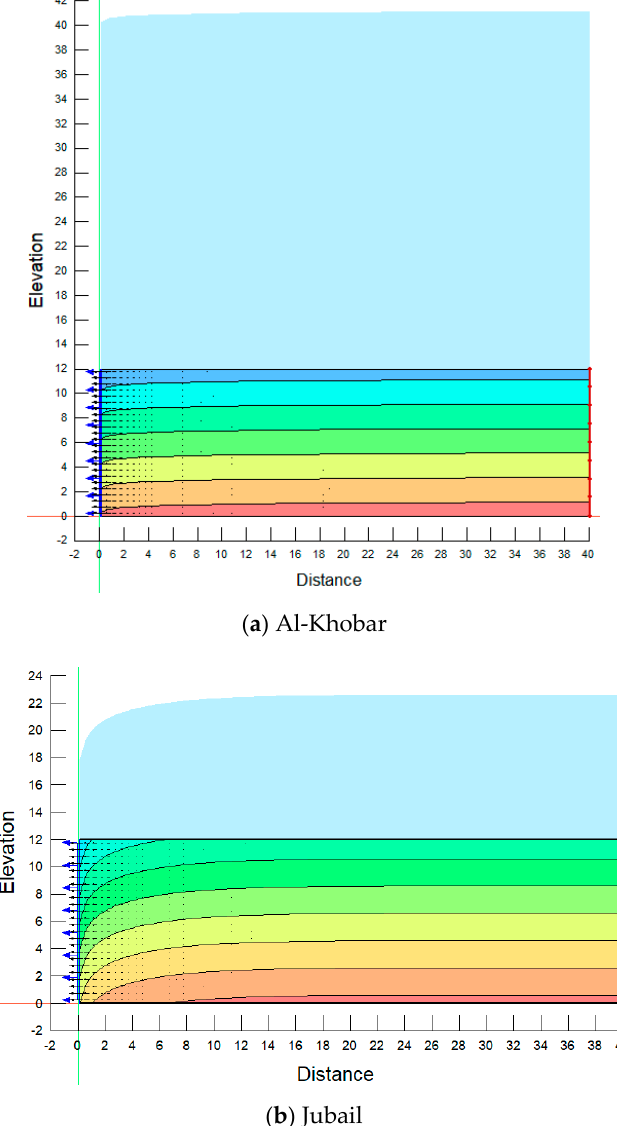
Figure 11. Contour lines for the drawdown curves for the ( a ) Al-Khobar and ( b ) Jubail sites (based on the observation well results).